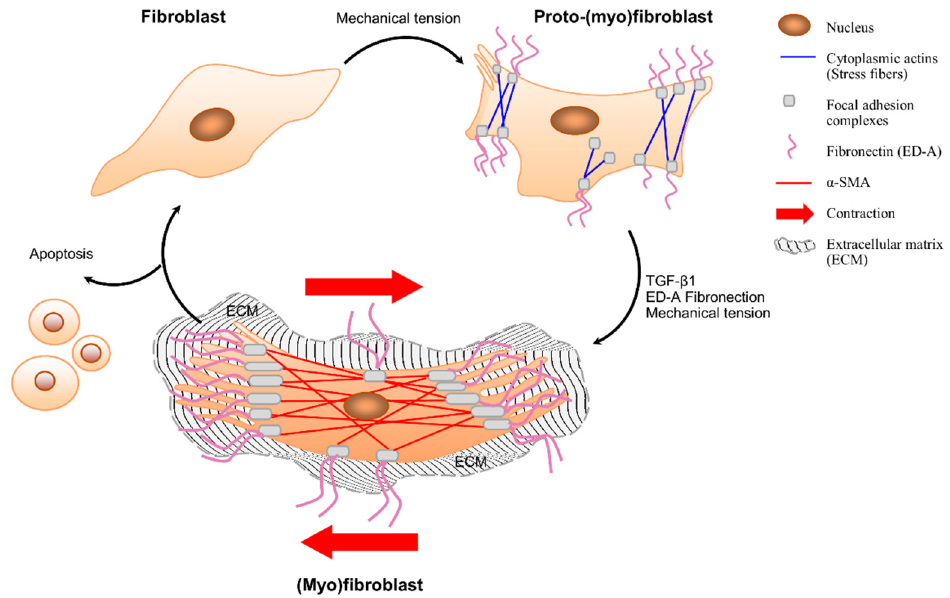
Figure 3. Fibroblast–(myo)fibroblast transition. Fibroblasts do not contain stress fibers or form adhesion complexes with their extracellular matrix. Fibroblasts become activated by mechanical stress and/or cytokine release and differentiate into “proto-(myo)fibroblasts” that form cytoplasmic actin-containing fibers, cell-matrix connections, and fibronectin—including ED-A splice variant (at the cell surface). Proto-(myo)fibroblasts can form contractile forces. In the presence of mechanical stress, TGF- β 1 and ED-A promote the transition of proto-(myo)fibroblasts to (myo)fibroblasts, which express α -SMA, larger cell-matrix connections, and extensively develop stress fibers. (Myo)fibroblasts produce ECM and have the ability to contract the surrounding tissue. (Myo)fibroblasts are cleared by apoptosis or may return to a quiescent fibroblastic phenotype after deactivation. The second step in the fibroblast–myofibroblast transition takes place due to the in-